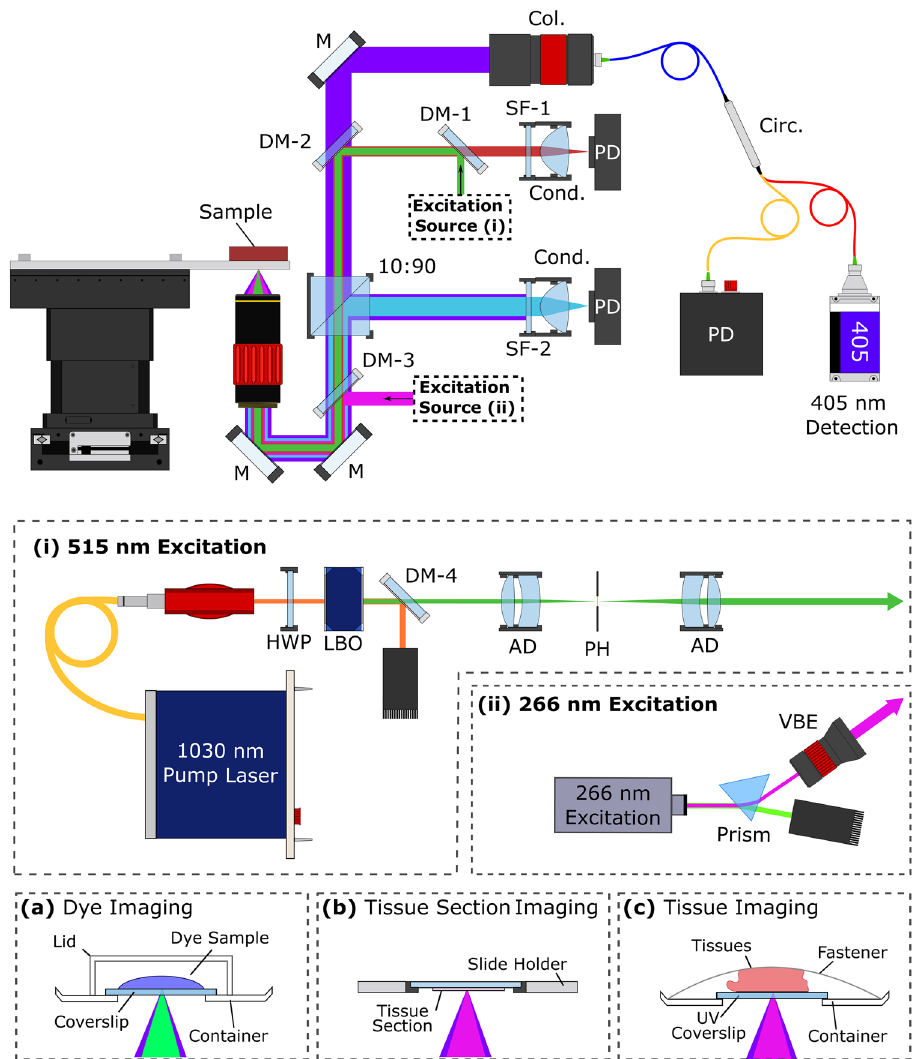
Figure 2. Simplified experimental system setups (i) 515 nm excitation system (b) 266 nm excitation system. ( a – c ) Sample configuration for imaging each type of tissue. Component labels are as follows: HWP half wave plate, LBO lithium triborate crystal, DM dichroic mirror, AD air spaced doublet, PH pinhole, VBE variable beam expander, Col. collimator, Circ. circulator, SF spectral filter, Cond. condenser lens, PD photodiode, 90:10 10:90 splitter, M